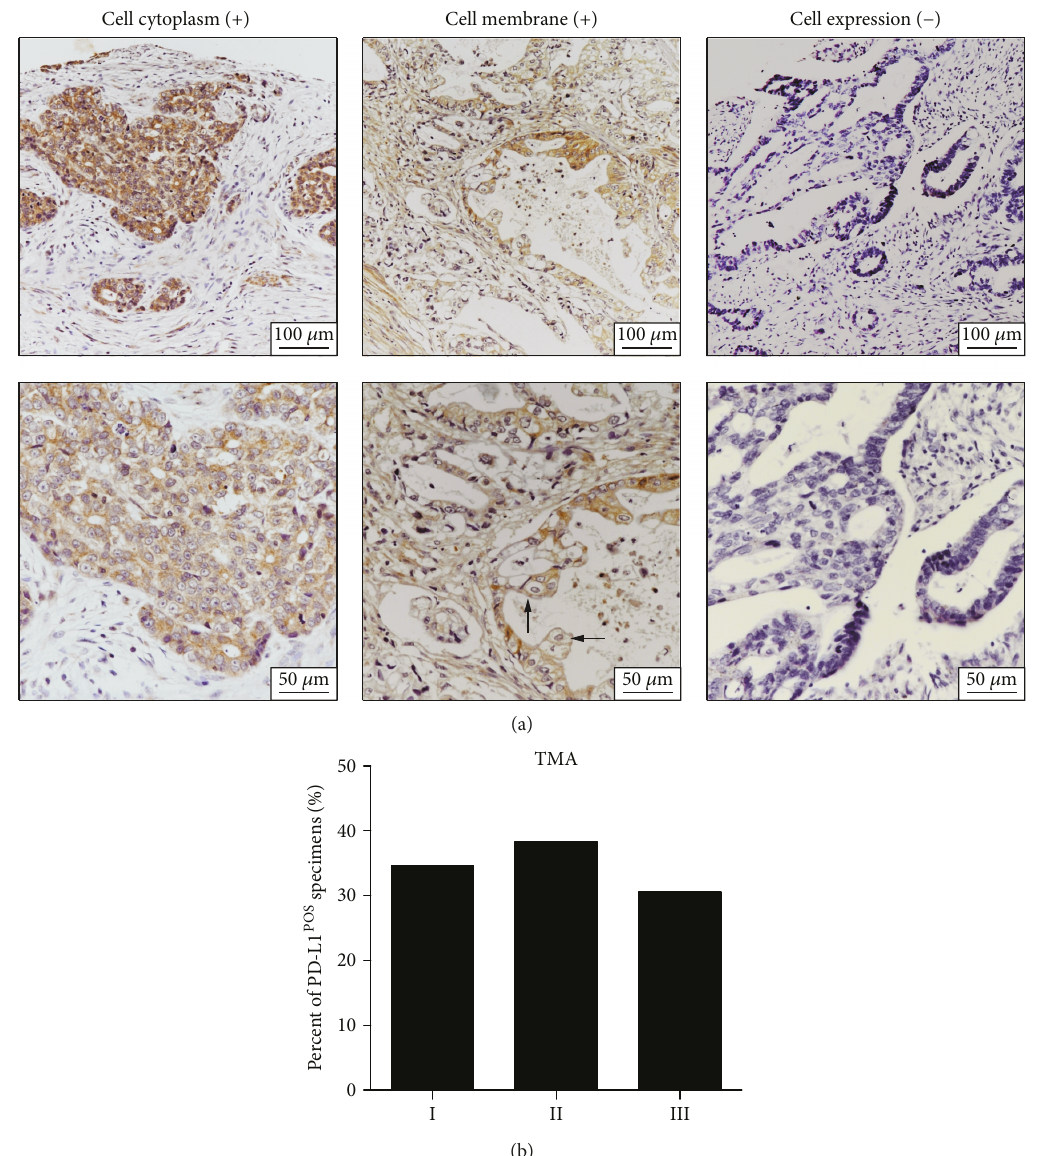
Figure 1: PD-L1 expression in AGCs. (a) Representative samples of IHC staining of PD-L1, including tumor cell cytoplasm staining, tumor cell membrane staining, and negative control, are presented . The lower panel (400x original magni fi cation) is the zoom-in image of the upper panel (200x original magni fi cation). The arrows indicate the membrane PD-L1 expression in tumor cells. (b) The percent of tumor PD-L1- positive specimens in TNM stage I, II, and III GC